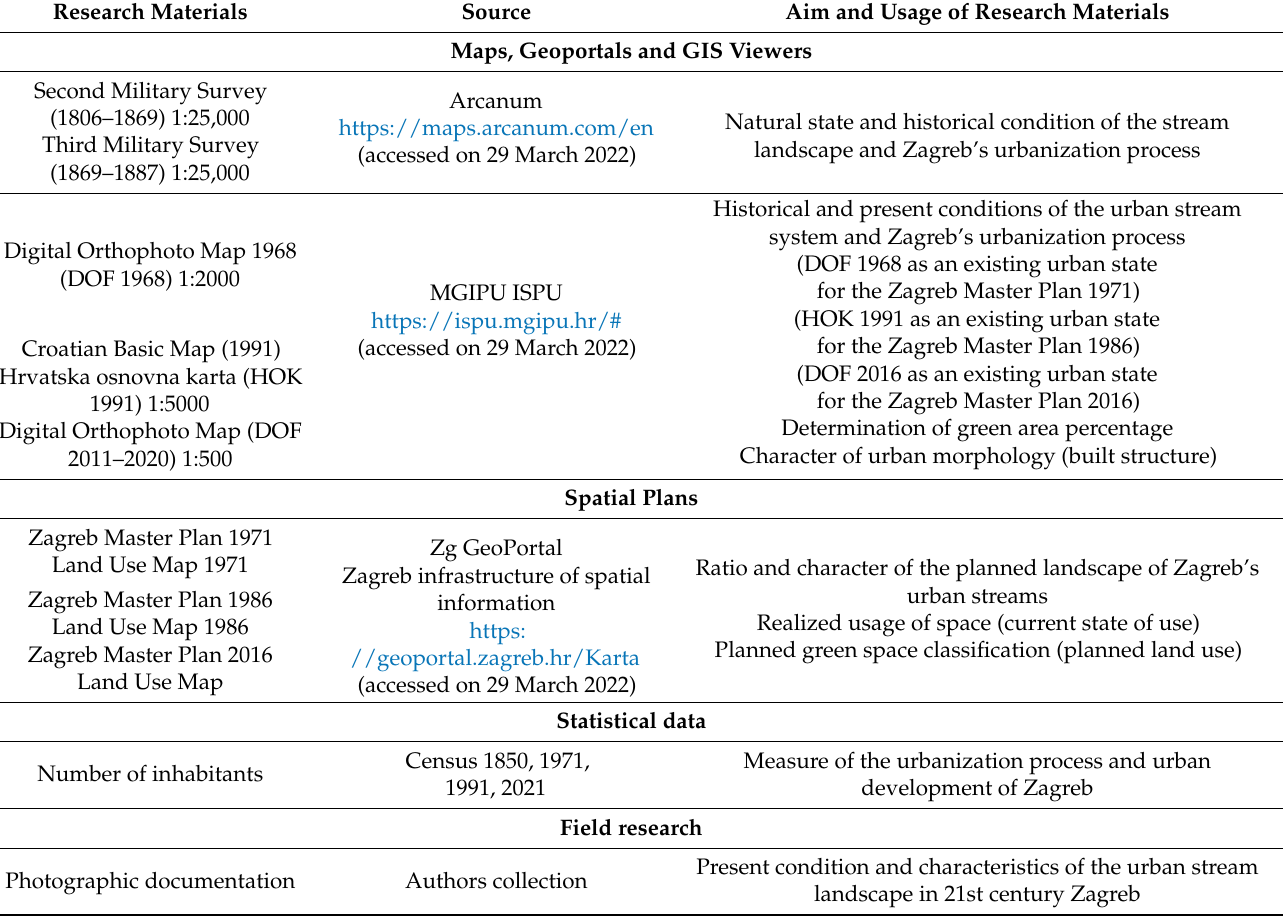
Table 1. Overview of research materials used in the analysis of dynamic changes in Zagreb’s stream